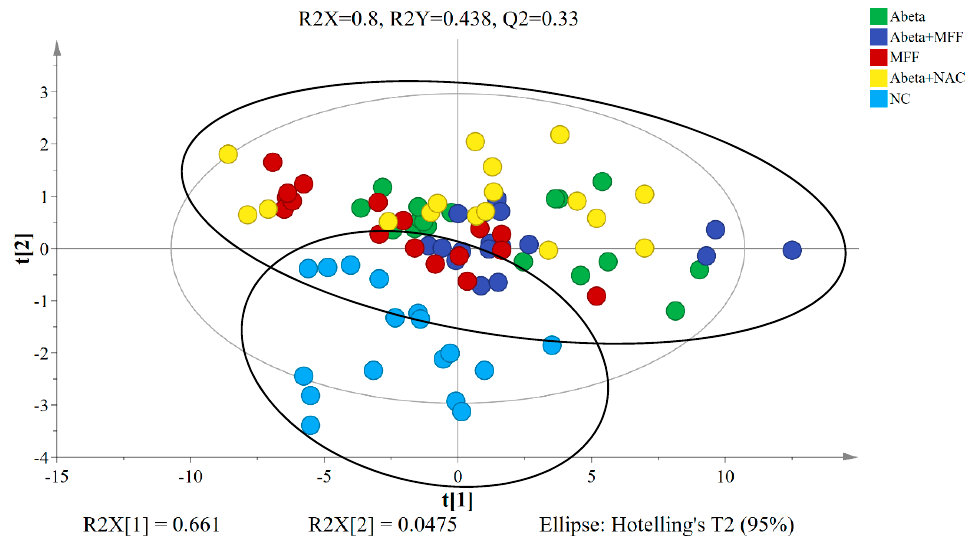
Figure 8. PLS − DA score plot based on the 1 H NMR data of the rat serum samples for all groups.